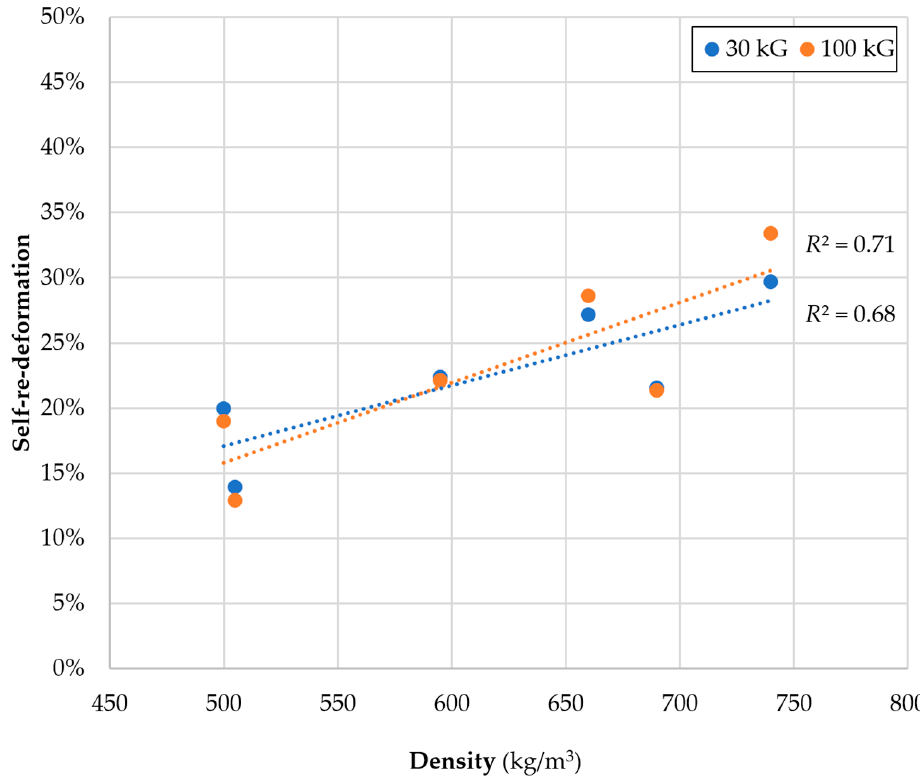
Figure 15. The ability of self-re-deformation in the L cross-section versus wood density.